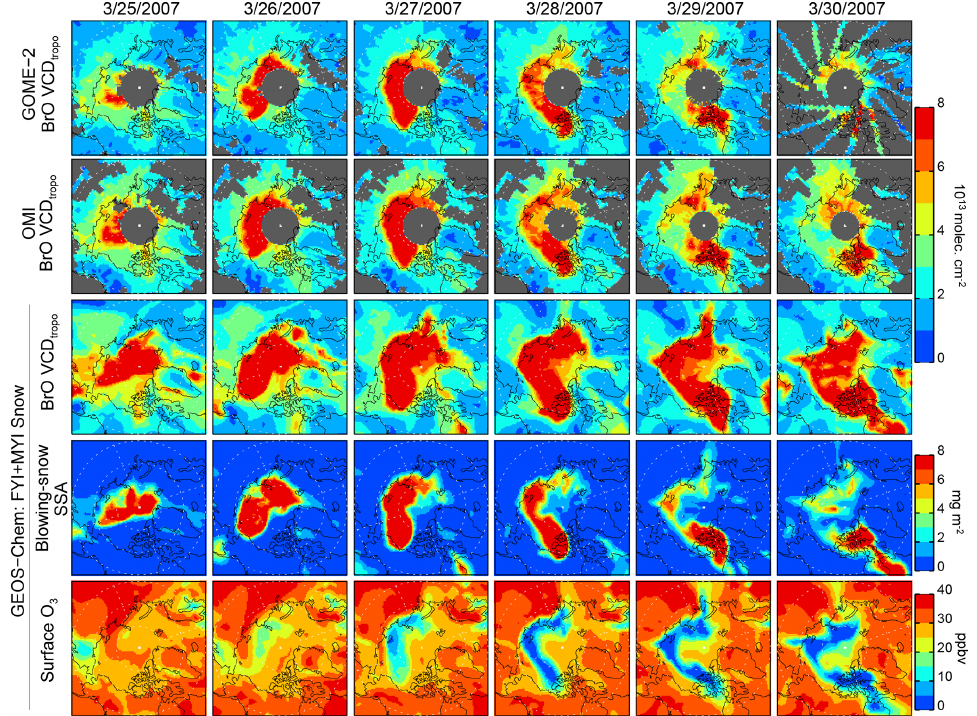
Figure 5. Daily 25–30 March 2007 (in the date format of month/day/year) distribution of BrO VCD tropo for GOME-2, OMI, and GEOS- Chem (FYI+MYI Snow simulation). Also shown are the blowing-snow SSA mass burdens (mgm − 2 ) and surface O 3 mixing ratios (ppbv) for the FYI+MYI Snow simulation. The gray areas in the first two rows correspond to regions with no BrO retrievals. Note that polar sunrise occurred equatorward of 80 ◦